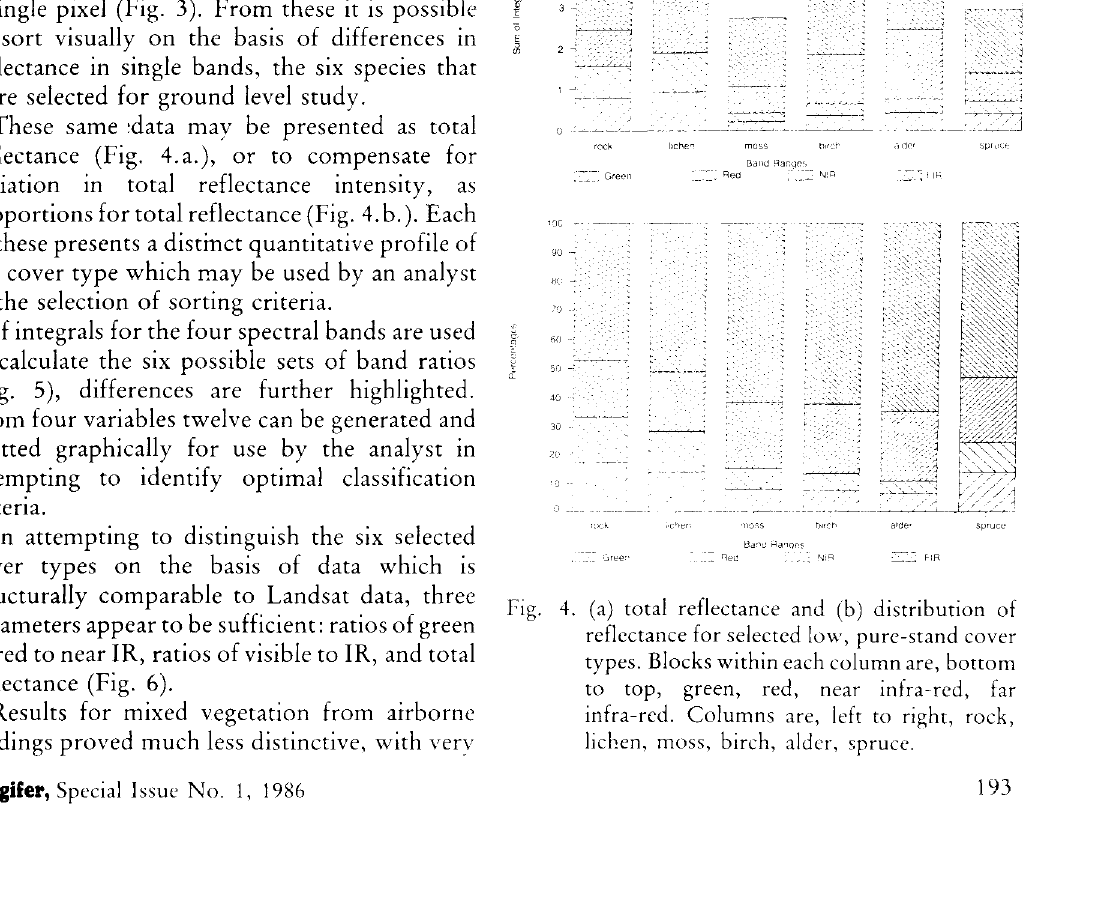
Fig. 4. (a) total reflectance and (b) distribution of reflectance for selected low, pure-stand cover types. Blocks within each column are, bottom to top, green, red, near infra-red, far infra-red. Columns are, left to right, rock, lichen, moss, birch, alder,